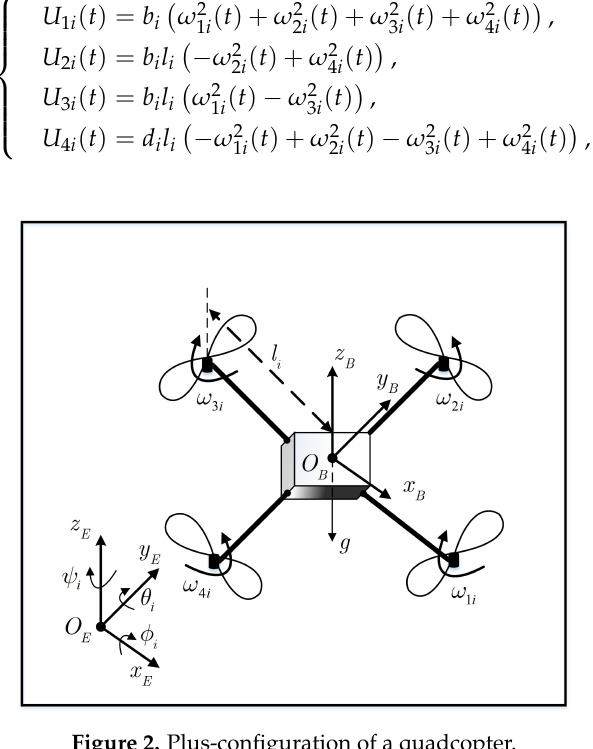
Figure 2. Plus-configuration of a quadcopter. Table 1. The quadcopter